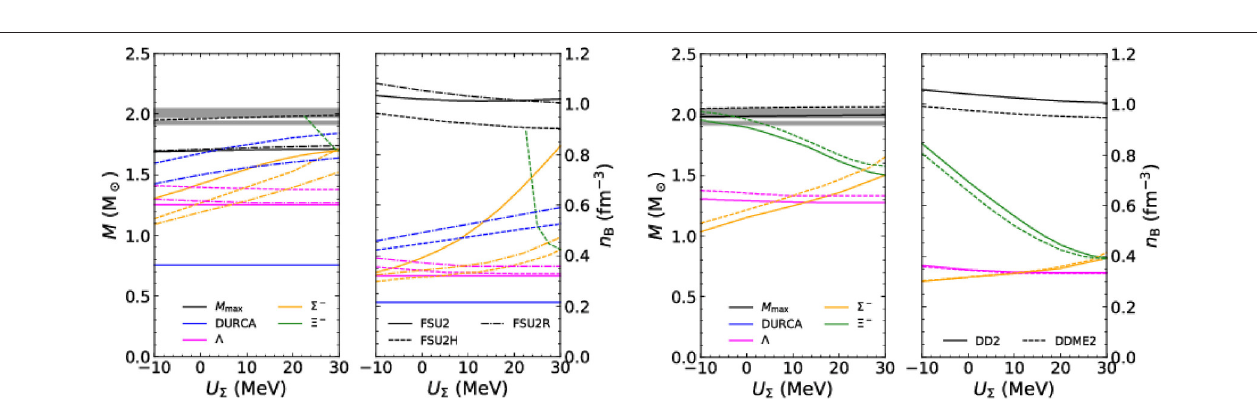
FIGURE 7 | (Left) For TM1, TM1 ωρ , TM1 σρ (solid, dashed, and dot-dashed lines) and (Right) TM1-2 and TM1-2 ωρ (solid and dashed lines), the onset density of the different hyperons ( 3 , 6 − , and 4 − ) (magenta, gold, and green lines), onset density of the DU process (blue lines), and NS central density at the maximum mass (black lines) (right) and the NS masses having as central densities the different densities plotted in the right panels (left).